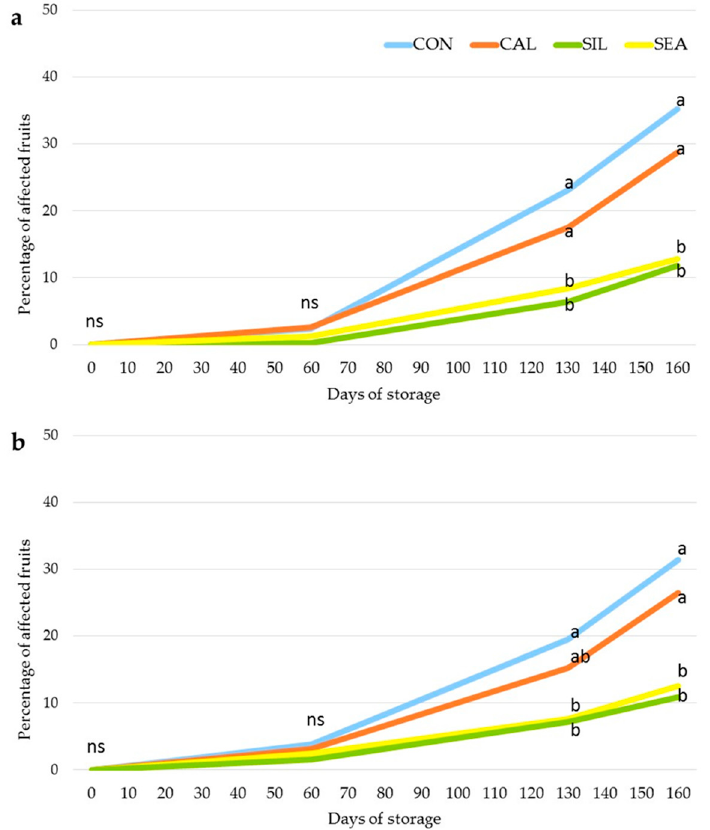
Figure 3. “Jonathan spot” disorder incidence in apples during storage (at 0, 60, 130, and 160 days) as affected by treatments in site 1 ( a ) and site 2 ( b ). For each evaluating period, letters indicate significant differences according to Tukey’s HSD post-hoc test; p < 0.05 (ns: not significant).